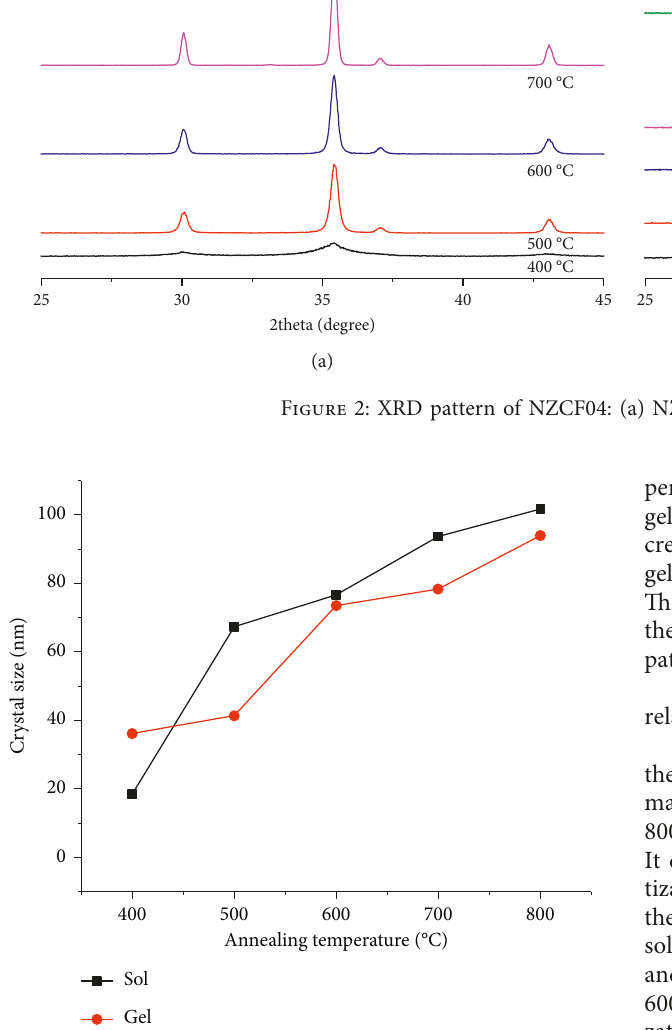
Figure 3: NZCF04 crystal size of the sol and the gel with annealing temperature.